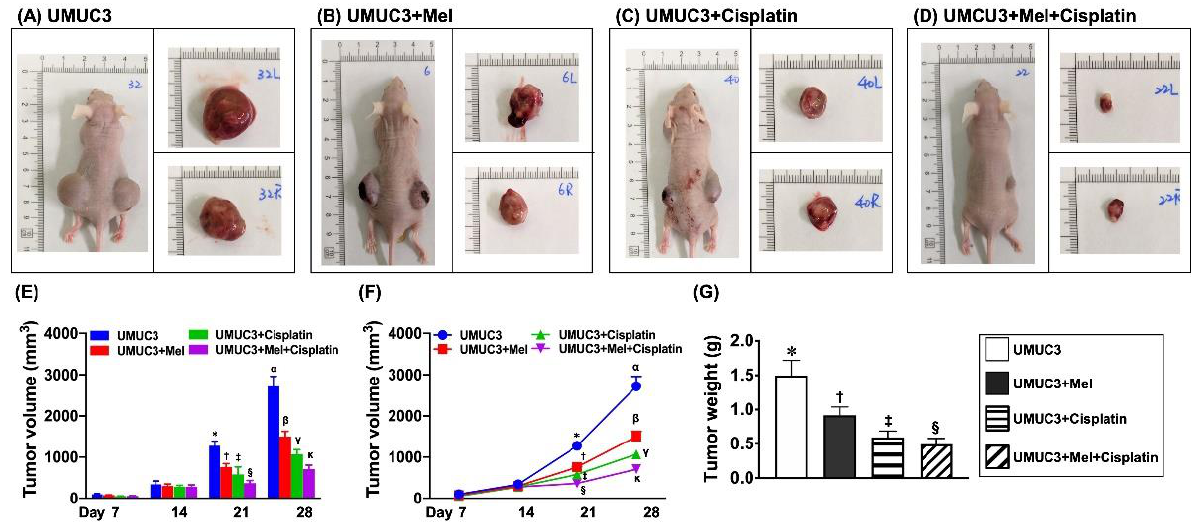
Figure 8. Serial changes of tumor volume and tumor weight on day 28 after UMUC3 bladder cancer cell engraftment into nude mouse backs. ( A – D ) Showing the grossly anatomical appearance of tumor masses in UMUC3 ( A ), UMUC3 + Mel (20 mg/kg/day) ( B ), UMUC3 + cisplatin (1 mg/kg/day) ( C ) UMUC3 + combined Mel-cisplatin ( D ) groups. The tumor size was remarkably diminished in UMUC3 +Mel, further remarkably diminished in UMUC3 + cisplatin and furthermore remarkably diminished in UMUC3 + combined Mel–cisplatin when compared to UMUC3 only by days 14, 21, and 28, respectively. ( E ) The analyses of the time points of tumor volume on days 7, 14, 18, 21, and 28. By days 7 and 14, the tumor volume did not differ among the four groups. On day 21, * vs. different symbols (†, ‡, and §), p < 0.0001. On day 28, α vs. different symbols (ß, γ , and κ ), p < 0.0001. ( F ) Revealing the time courses of the growth of tumor volume size. The analytical results on the time intervals of days 7, 14, 18, 21, and 28 were exactly identical to ( E ). ( G ) On day 28, the tumor weight, * vs. different symbols (†, ‡, and §), p < 0.0001. n = 10 for each group. Mel = melatonin.